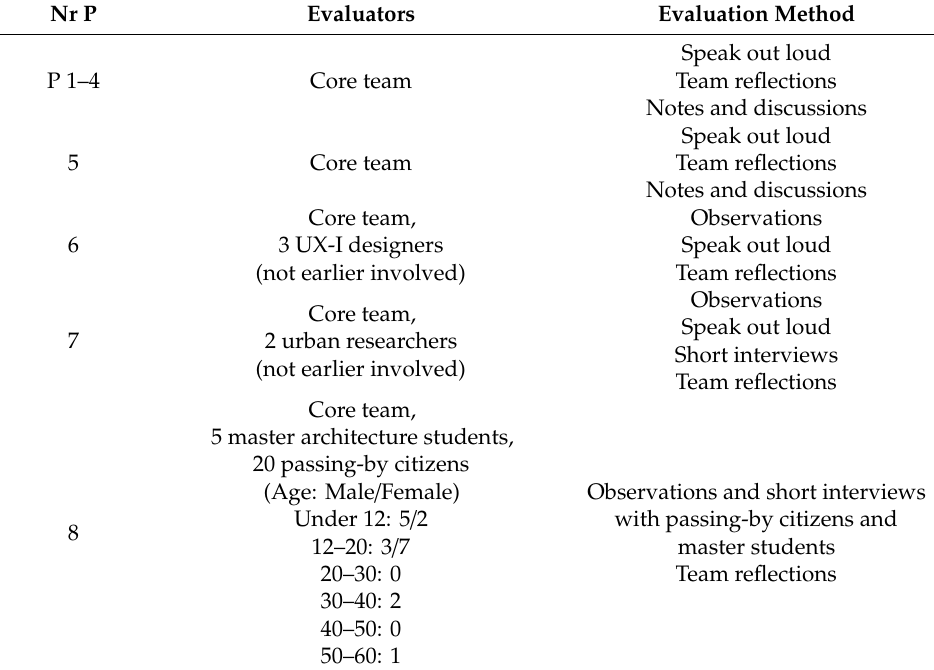
Table 2. Evaluators of each prototype. P = Prototype; core team = 1–2 urban researchers and two software